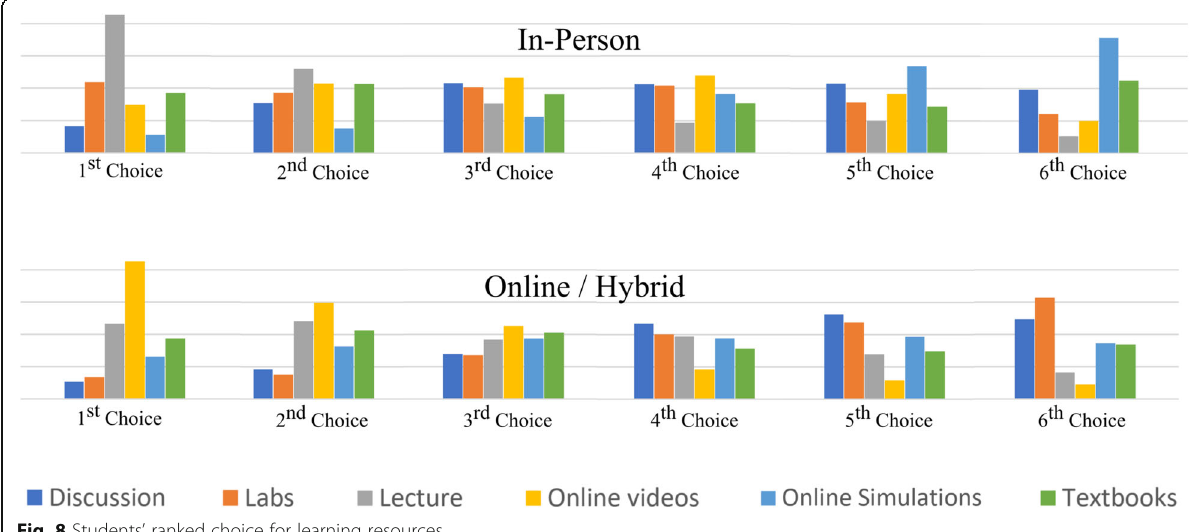
Fig. 8 Students ’ ranked choice for learning